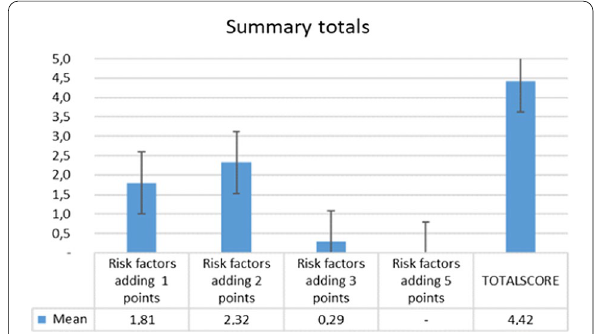
Fig. 2 Mean contribution from each risk factor category and total Caprini score in the sample population